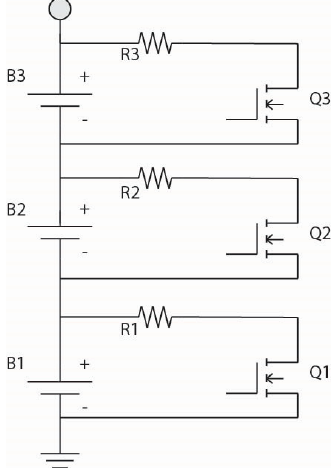
Figure 1. Passive equalizer (PEQ) for 3 cells.